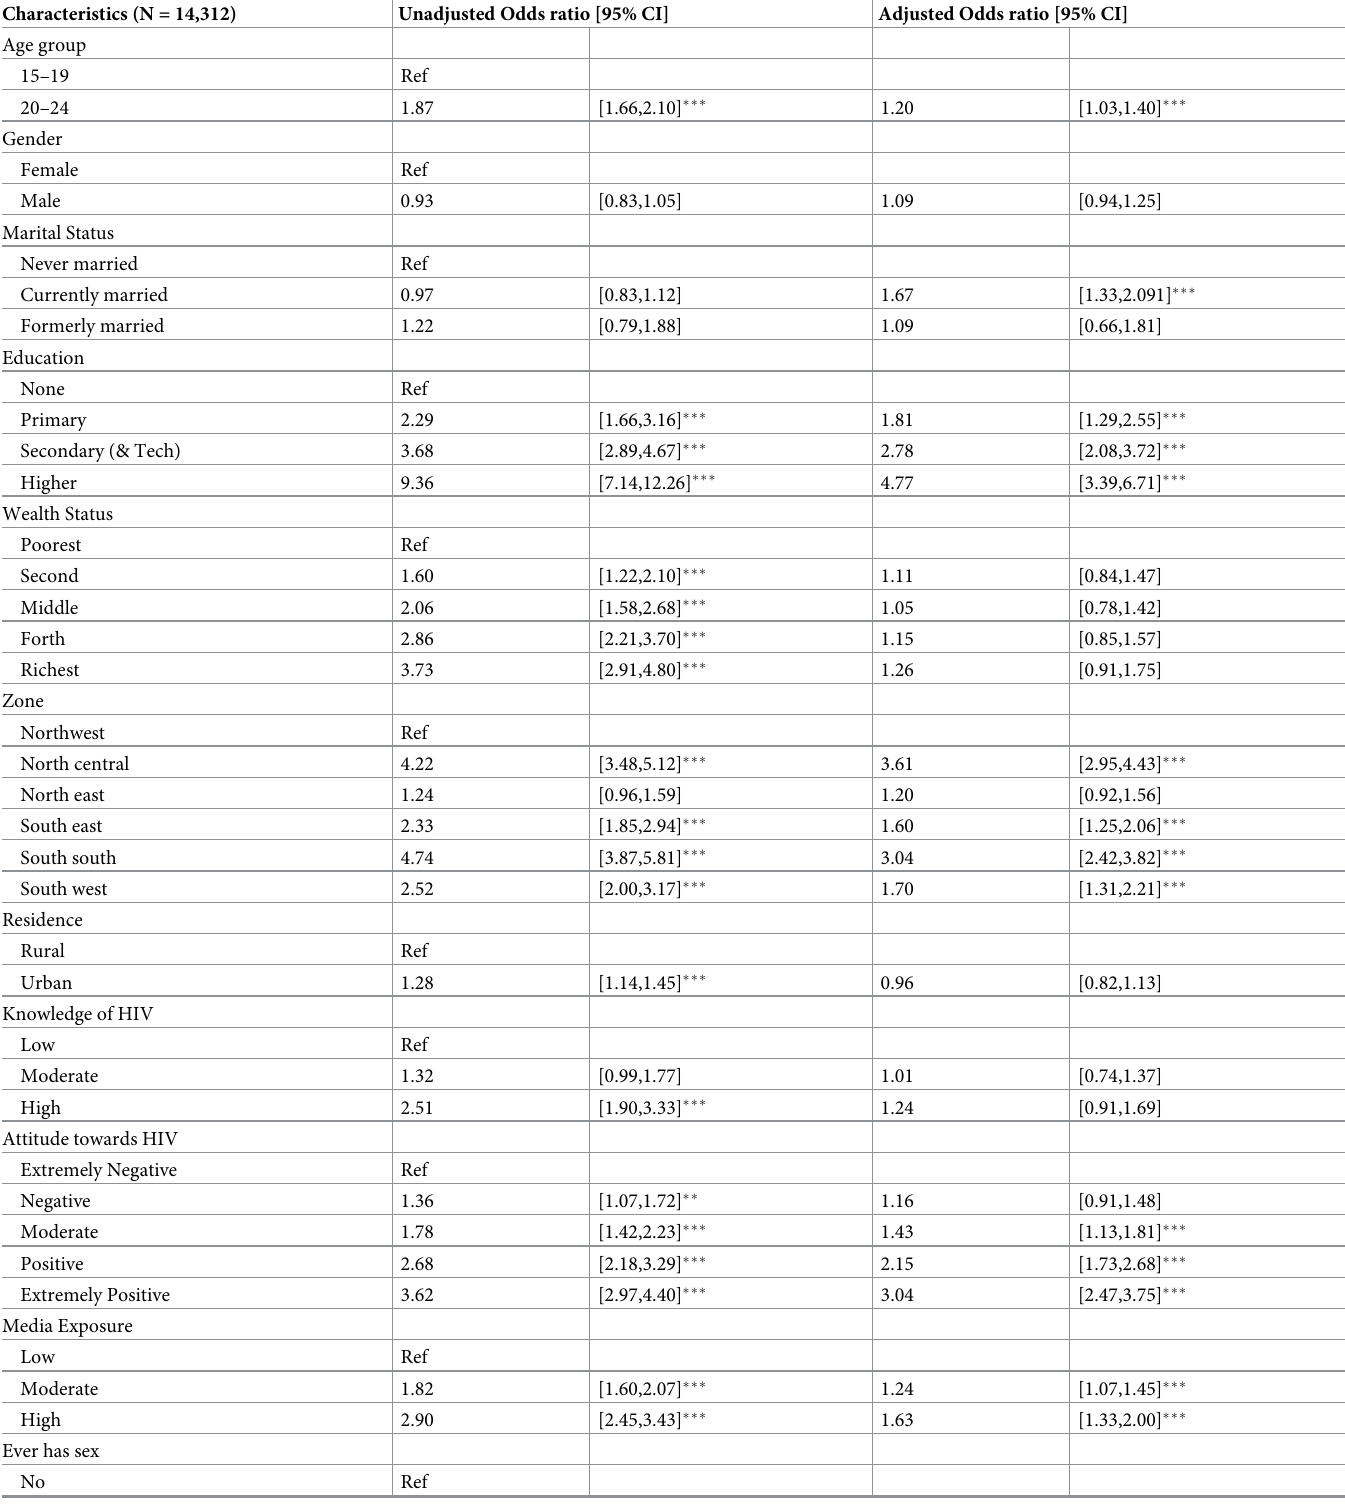
Table 5. Multivariable logistic regression analysis showing predictors of recent uptake of HIV